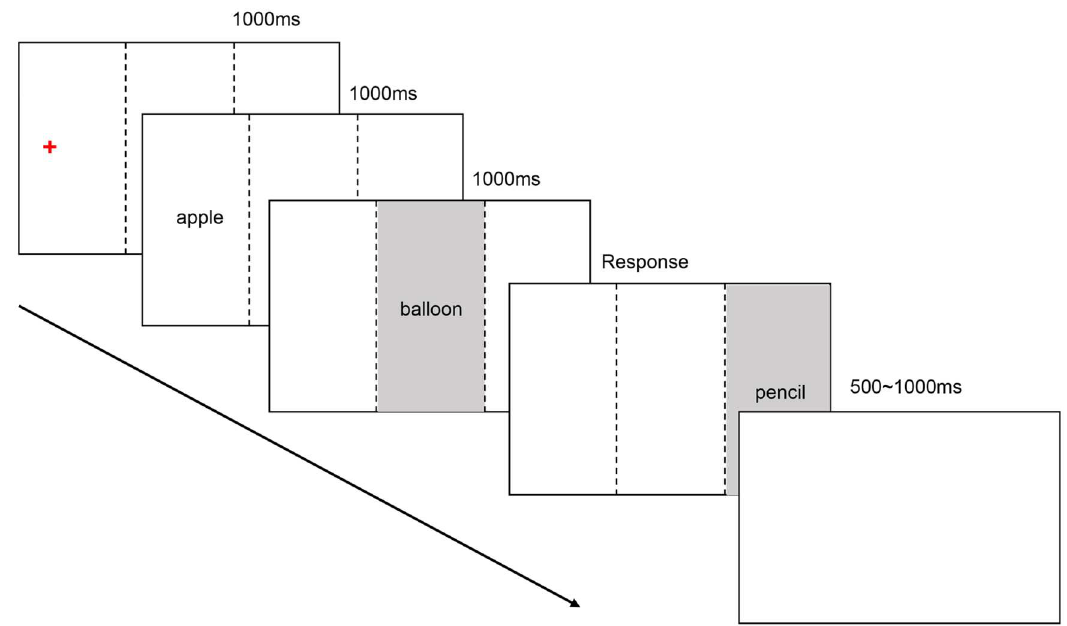
Fig 3. Presentation of stimuli in Experiment 2. Stimuli were presented subsequently in the same position and sequence like Experiment1, with time interval of 1000ms. The first word and second word would appear on the screen for 1000ms, the last word would kept seen until the participanthas made a reaction. Between each trial, there was a blank screen of 500ms to 1000ms